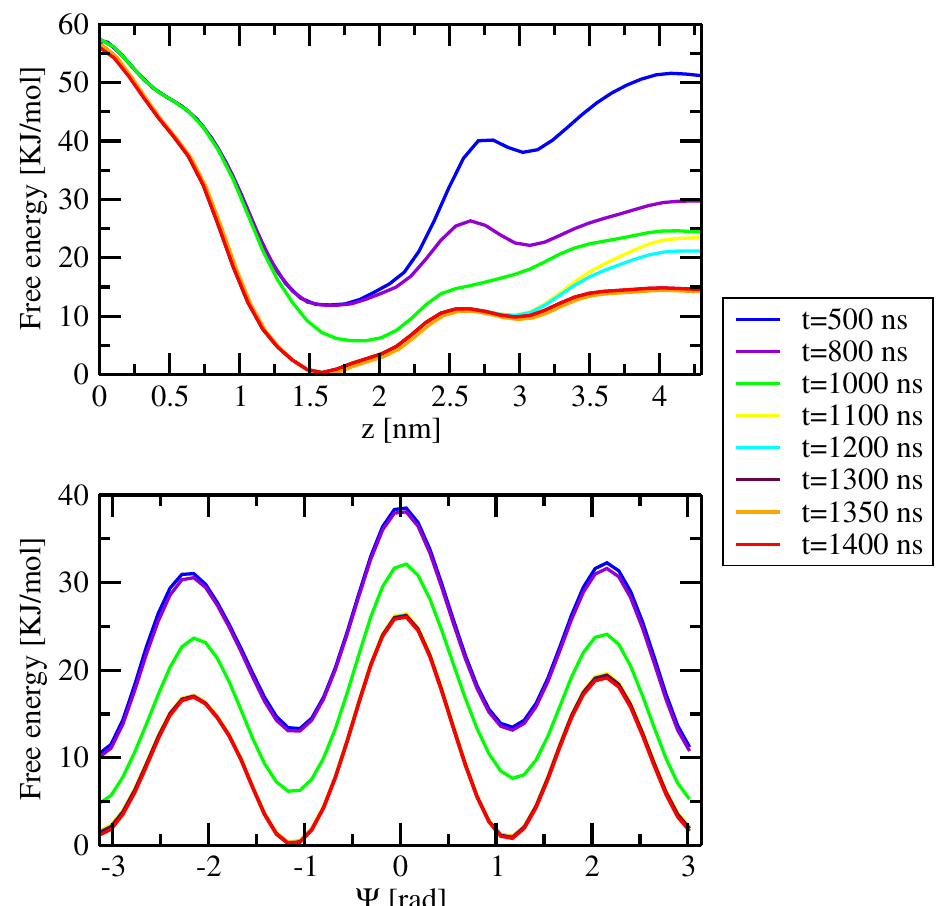
Figure A2. Time cumulative free energy profiles at the 30% cholesterol system. Bottom: CV1, top: